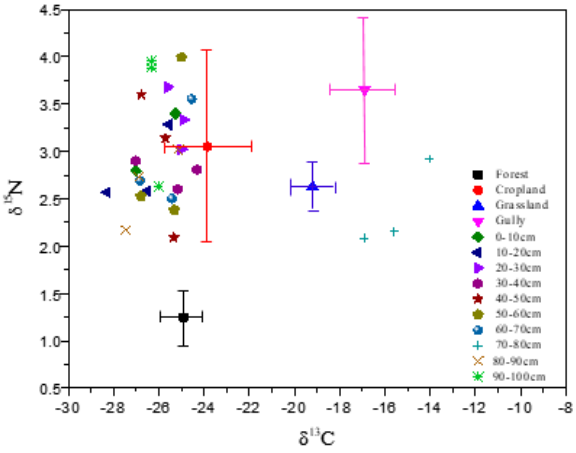
Figure 6. Correlation between δ 13 C and δ 15 N in the source soils and sediments. (Horizontal and vertical bars denote 95% confidence intervals).